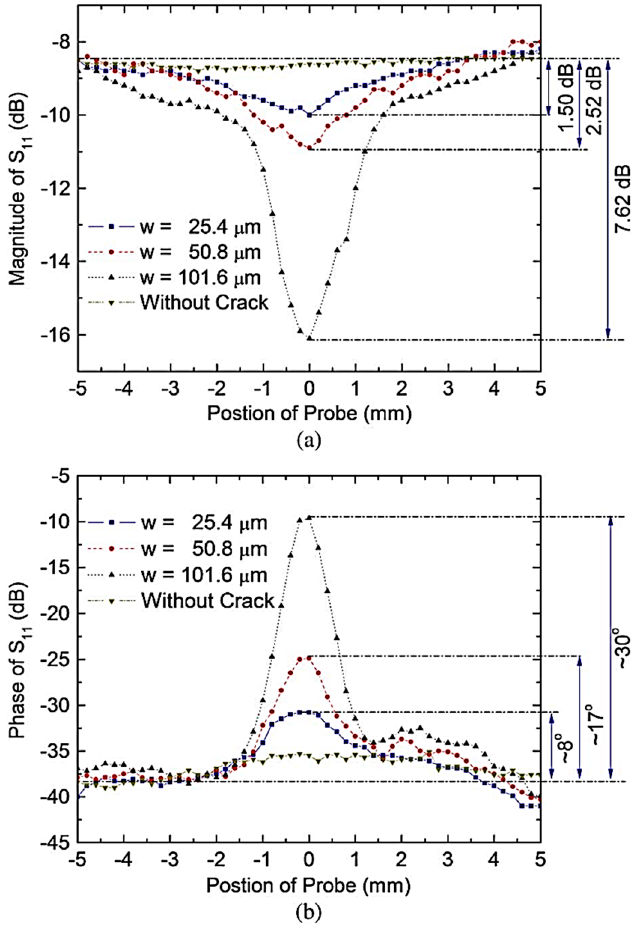
Figure 26. Experimental results for testing cracks with different widths: ( a ) magnitude response for the probe position and ( b ) phase response for the probe position. “ w ” is the width of the crack (from [40]; copyright © IEEE 2014; reproduced with permission).